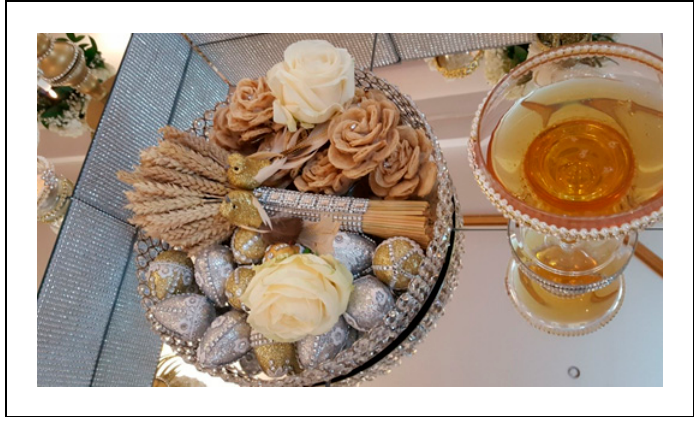
Figure 3. Bread in the shape of flowers, corn, and eggs. Picture delivered by Um Zahra in London